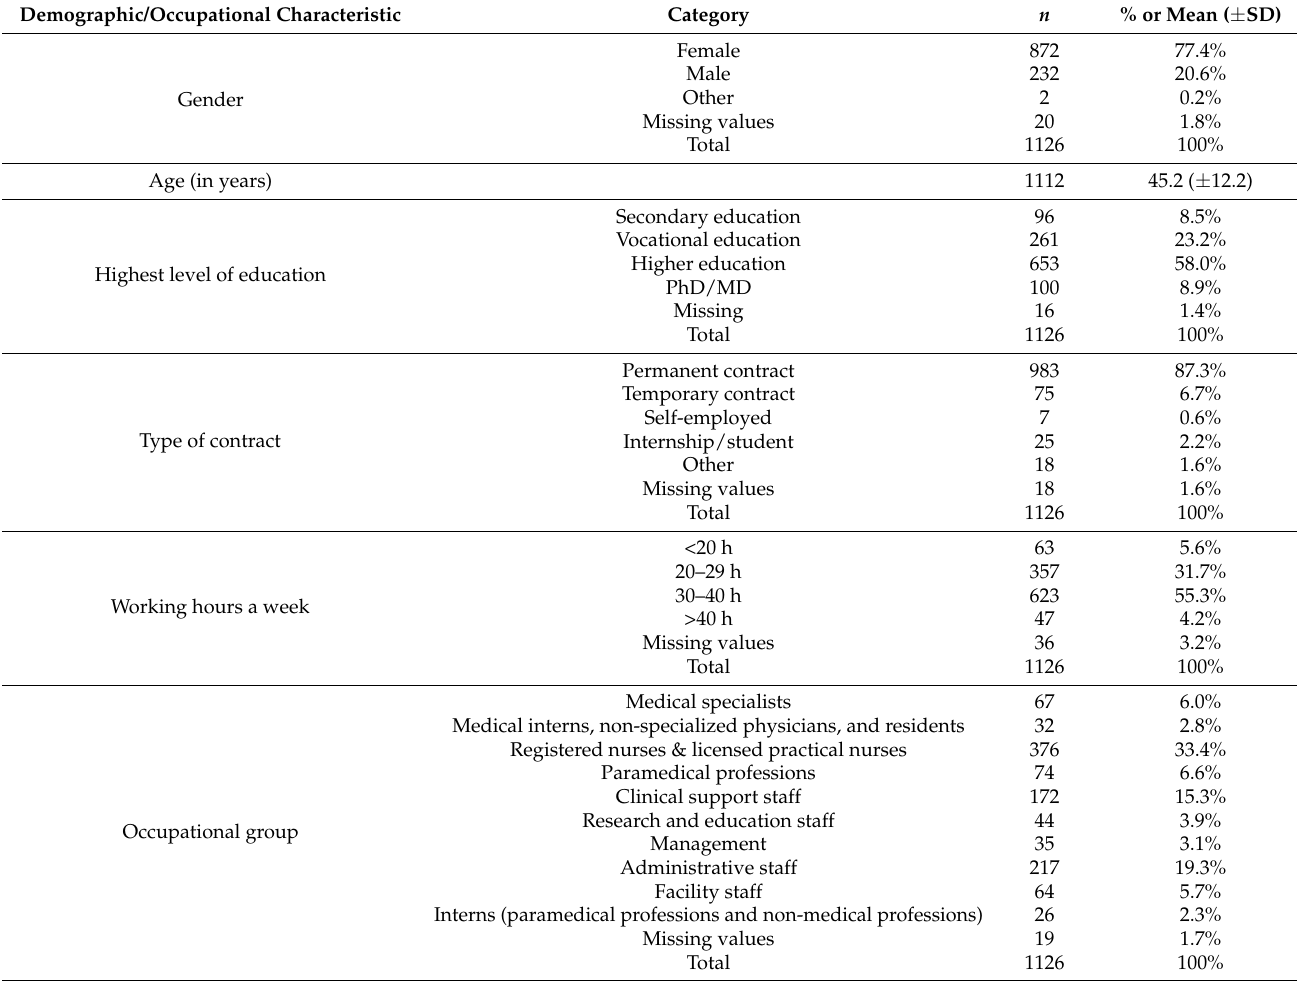
Table A1. Demographic and occupational characteristics of the